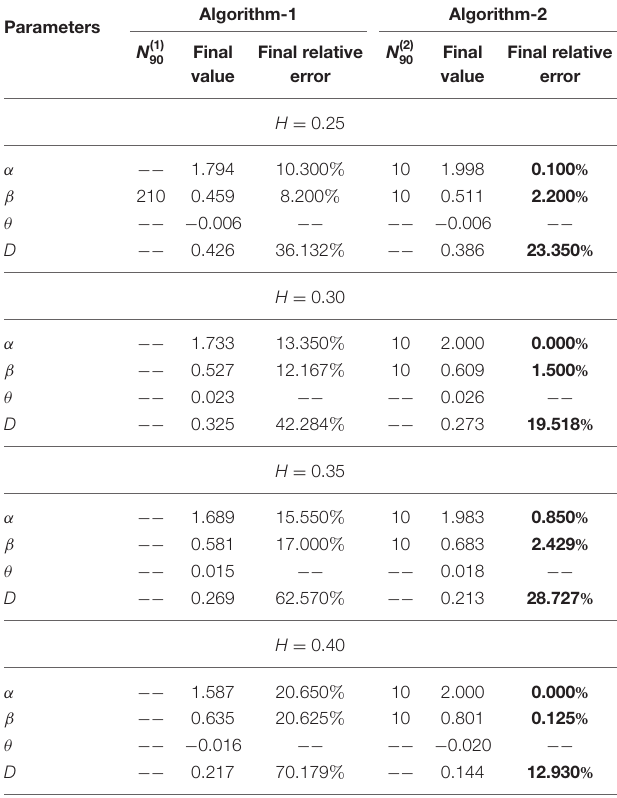
TABLE 4 | Numerical results for fBm parameter estimation.